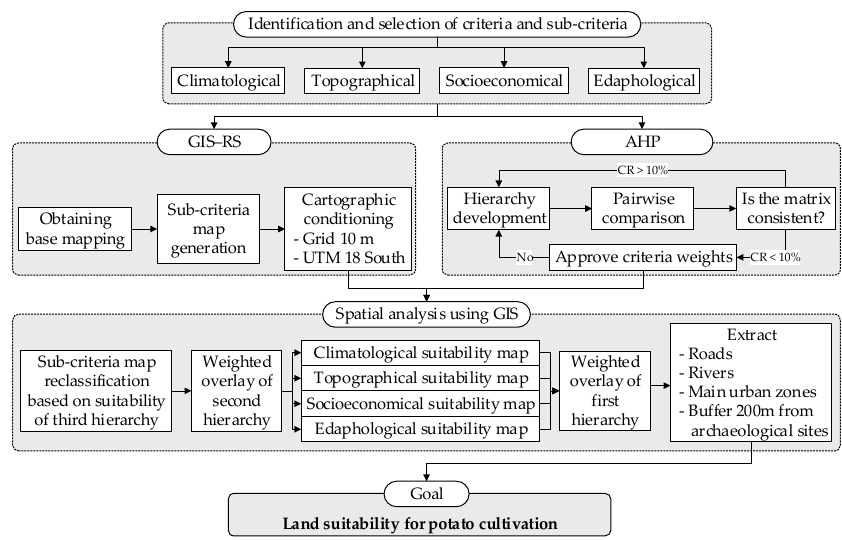
Figure 2. Research framework for land suitability modelling for potato cultivation in the Jucusbamba and Tincas microwatersheds (Amazonas, NW Peru).